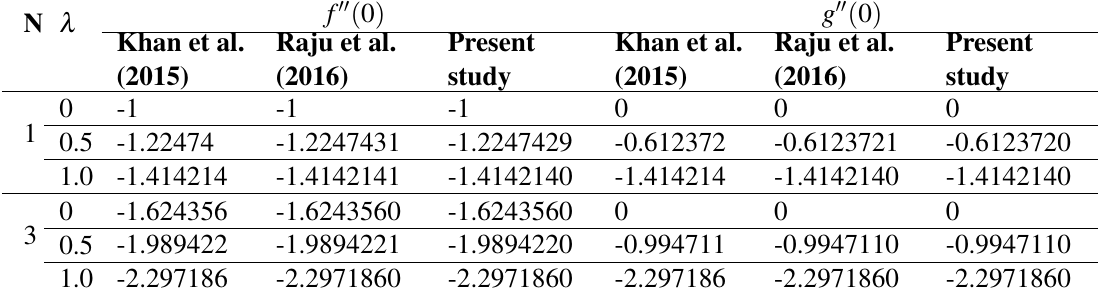
Table 1 Comparisons for the values of f (cid:48)(cid:48) ( 0 ) and g (cid:48)(cid:48) ( 0 ) in the absence of magnetic field N λ